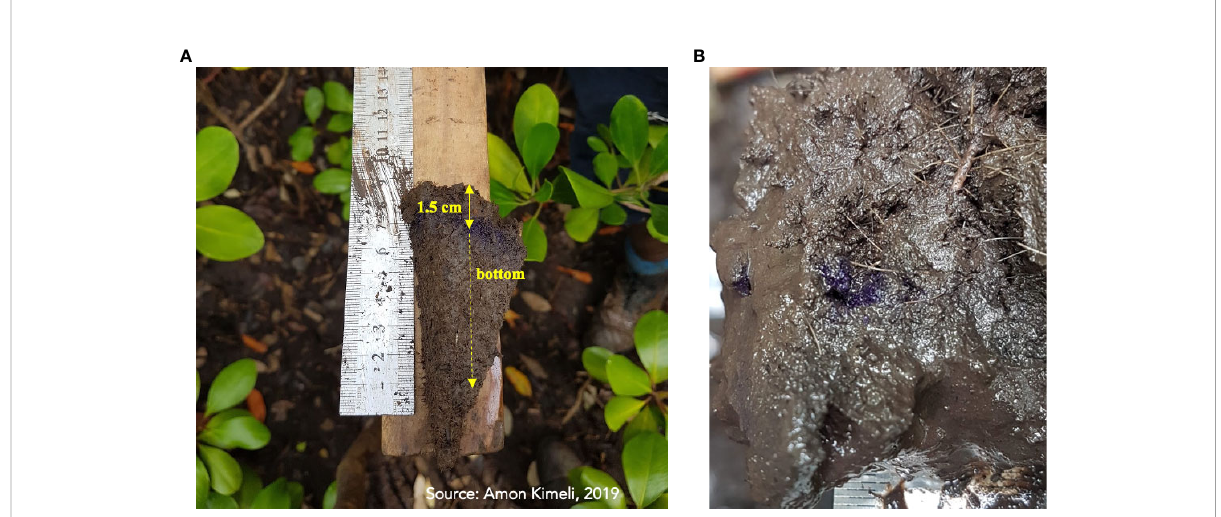
FIGURE 8 (A) Image showing the cored sediments with discernible sediment accretion in station 13A and (B) image showing the effects of crab mud overturning and mixing (in some of the plots set up (e.g., in stations 9A, 16A,